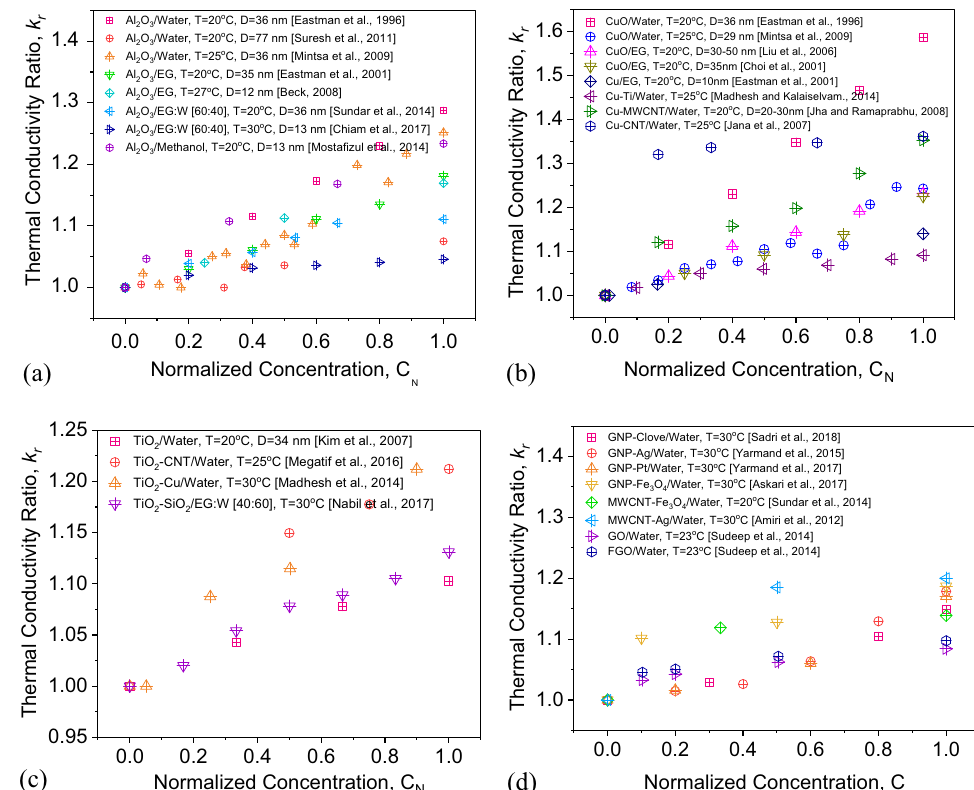
Figure 4: E ff ect of nanoparticle ’ s concentration on thermal conductivity: ( a ) Al 2 O 3 , ( b ) Cu and CuO, ( c ) TiO 2 , and ( d ) carbon